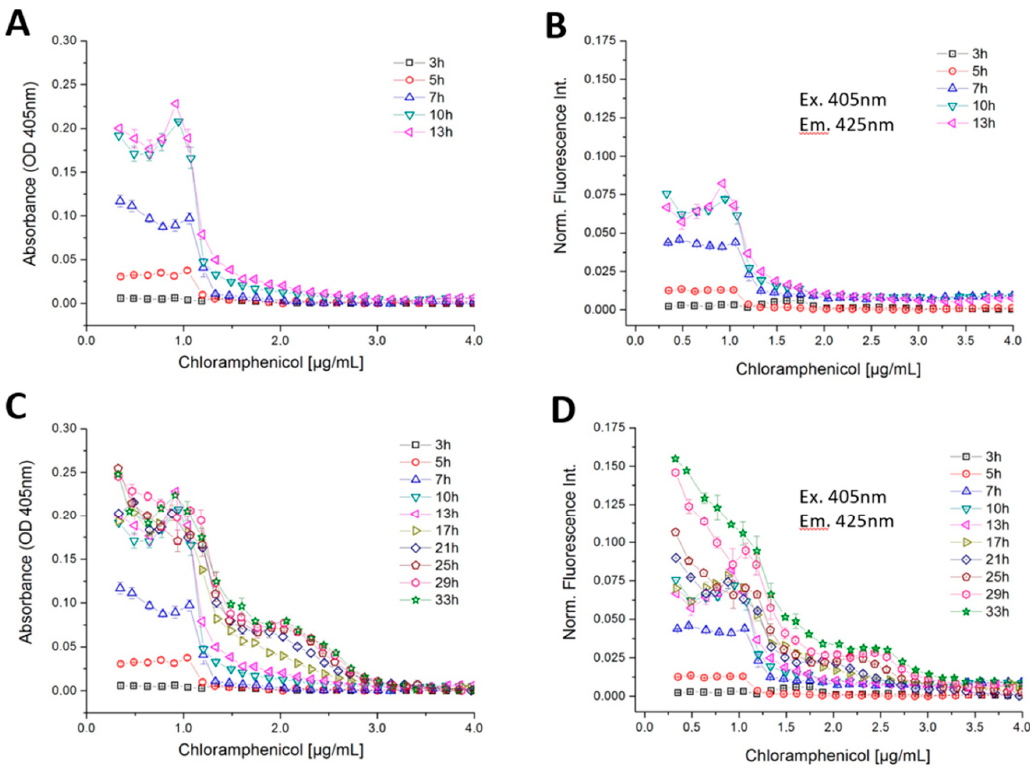
Figure 12. Highly concentration and time-resolved dose–response curves of B. megaterium against chloramphenicol based on ( A ) optical density of an incubation time of 3 to 13 h, ( B ) autofluorescence intensity of an incubation time of 3 to 13 h, ( C ) optical density of an incubation time of 3 to 33 h, ( D ) autofluorescence intensity of an incubation time of 3 to 33 h.